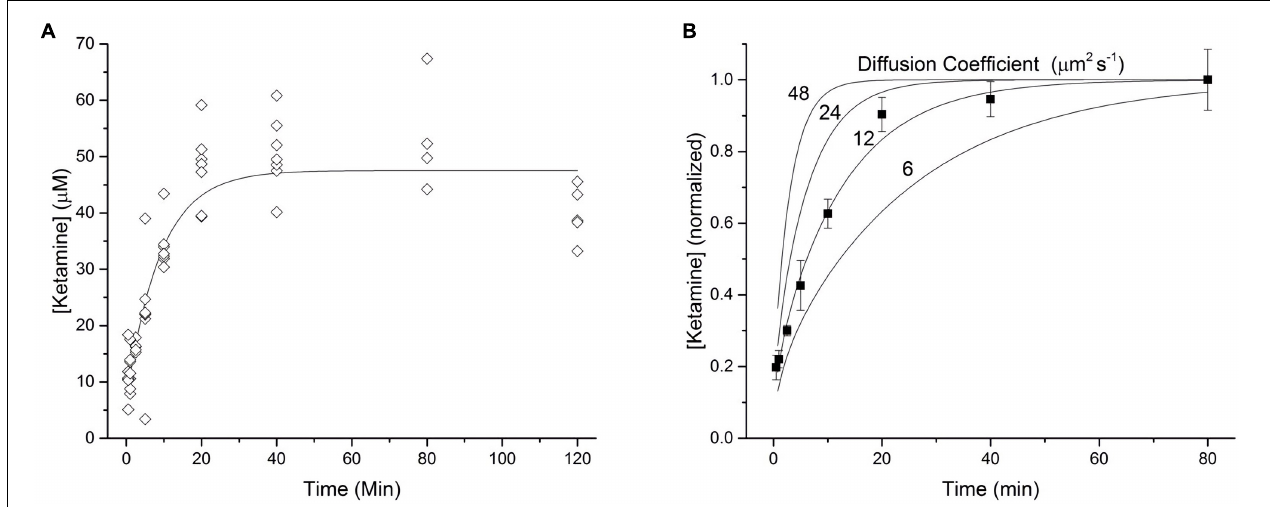
FIGURE 1 | Kinetics of ketamine diffusion into brain tissue. (A) 300 micron thick brain slices were incubated in a 17.1 µ M solution of ketamine HCl dispersed in ACSF for various lengths of time ranging from 0.5 to 120 min ( n = 4–7 slices for each time point, N = 6 mice). Each point represents the average tissue concentration of ketamine within a single brain slice. The line of best fit represents a mono-exponential function with a time constant of τ = 6.59 min. (B) A one-dimensional model of diffusion was used to generate four curves representing the diffusion of a hypothetical drug, over a range of diffusion coefficients, into both the top and bottom surfaces of a 300 micron thick brain slice. Average tissue concentrations of ketamine, normalized to the average concentration observed at 80 min, were plotted against these curves to estimate the diffusion coefficient of ketamine in brain tissue. Each point represents the mean value at each time point from A bounded by the corresponding standard error of the